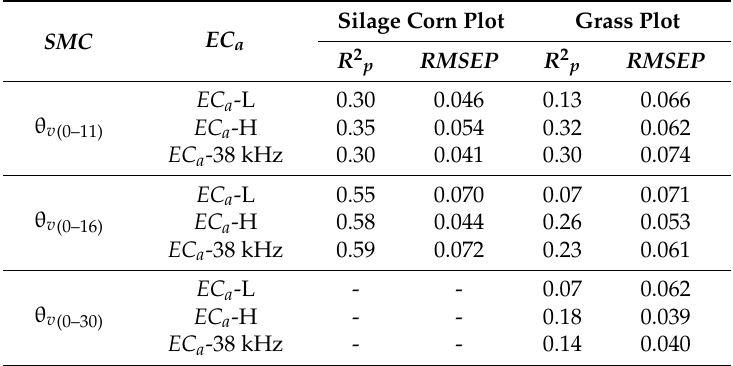
Table 5. Validation of the fitted linear regressions summarised in Table 4, using EC a data